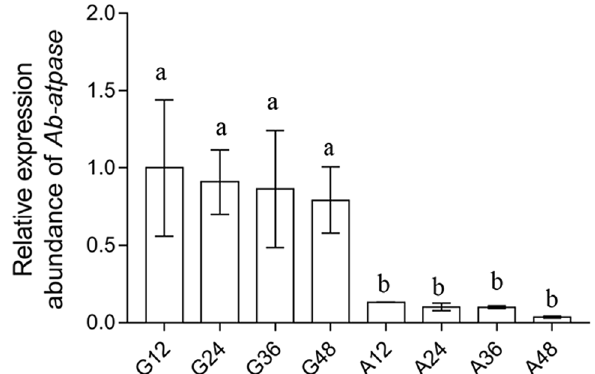
Figure. 6. Expressions of the Ab-atps mRNA in Aphelenchoides besseyi treated with Ab-atps double-stranded (ds) RNA. G12, G24, G36, and G48: Expressions of Ab-atps mRNA in nematodes that soaked in non- endogenous gfp dsRNA solution for 12 h, 24 h, 36 h, and 48 h, respectively; A12, A24, A36, and A48: Expression of Ab-atps mRNA in nematodes that soaked in Ab-atps dsRNA for 12 h, 24 h, 36 h, and 48 h, respectively. Standard errors of mean data (n = 5) were indicated by bars and significant differences ( p < 0.05) between treatments were indicated by letters.